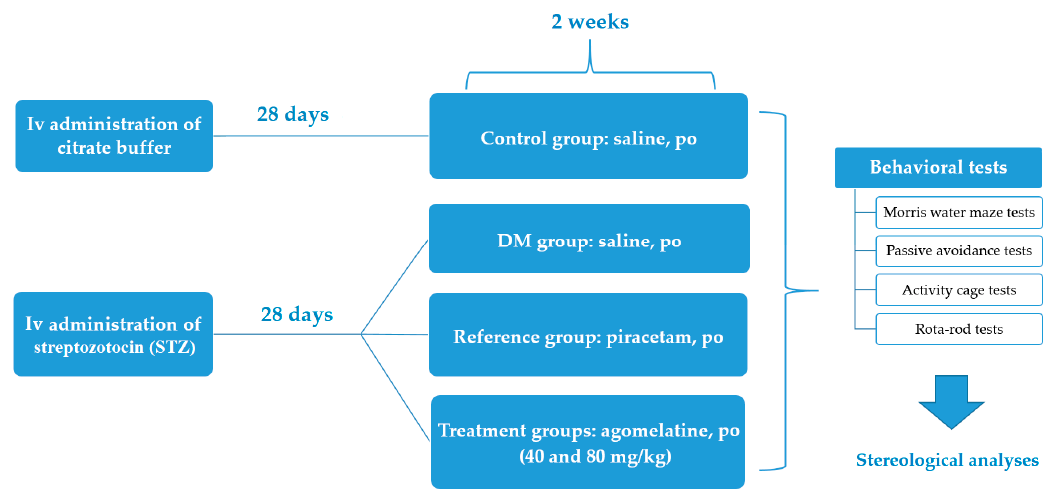
Figure 1. Brief summary of the experimental design.